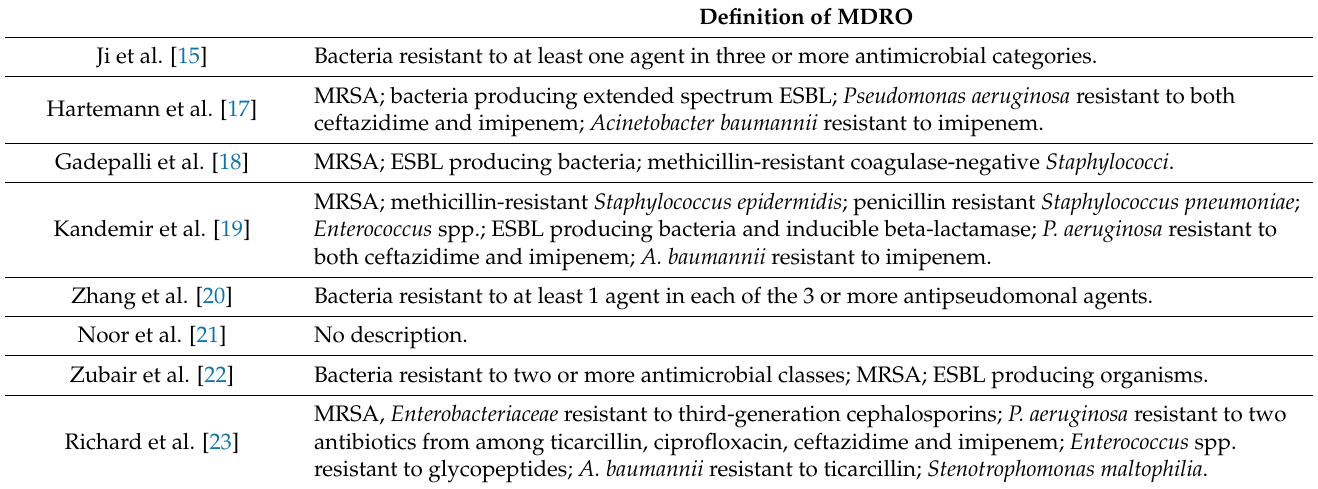
Table 4. Definition of multidrug-resistant organisms that was chosen by each